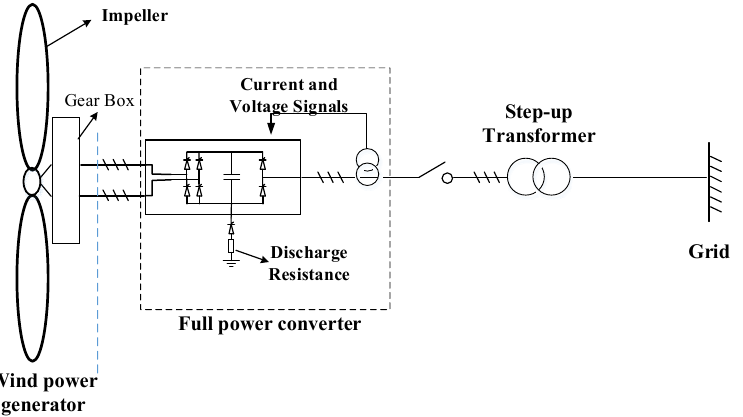
Figure 4. Schematic of a constant voltage control mode wind turbine.